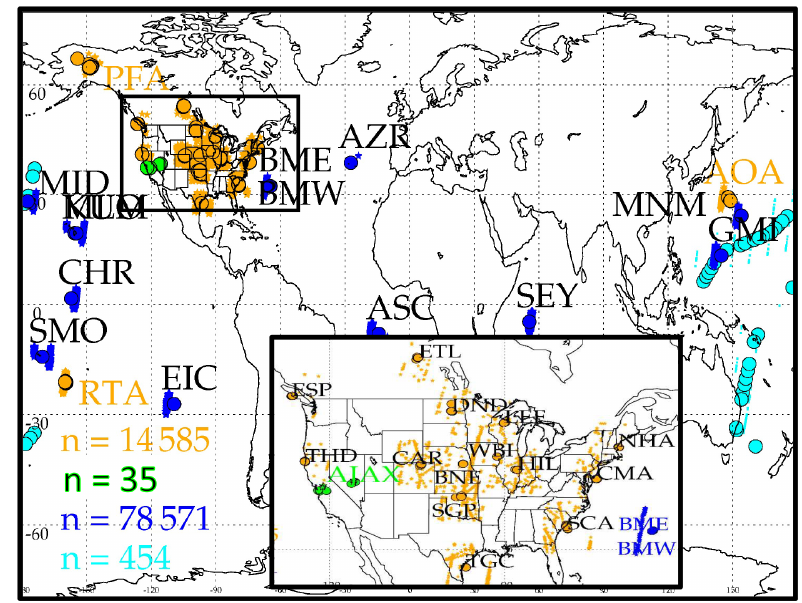
Figure 2. Validation locations. The four sets of validation data shown here are ESRL aircraft profiles (orange), which occur over land (in the US) and ocean (RTA, Rarotonga, and AOA), AJAX aircraft data (green) in the western US, the HIPPO aircraft profiles (light blue), and remote ocean surface sites (dark blue). The matching GOSAT locations are shown as stars and the validation locations are shown as outlined circles. The number of GOSAT observations in each set are shown as the “ n = ” number in the lower left of the